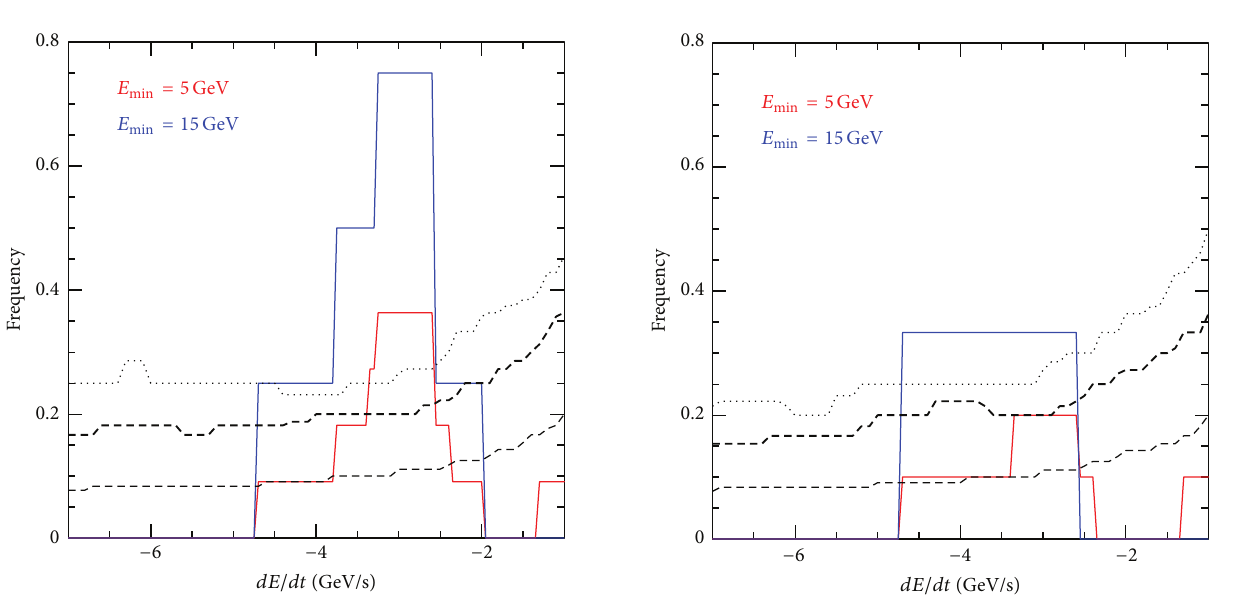
Figure 9: Here shown are the results of a study exactly of the type already described in the previous Figure 7 (including the restriction to the time interval from 190 seconds to 640 seconds after the trigger), but now excluding from the analysis a 19GeV event from about 250 seconds after trigger. Dotted/dashed lines represent again the 10 %, 1 % and 0.23 % probability that the given frequency of occurrence of spectral lags is a chance